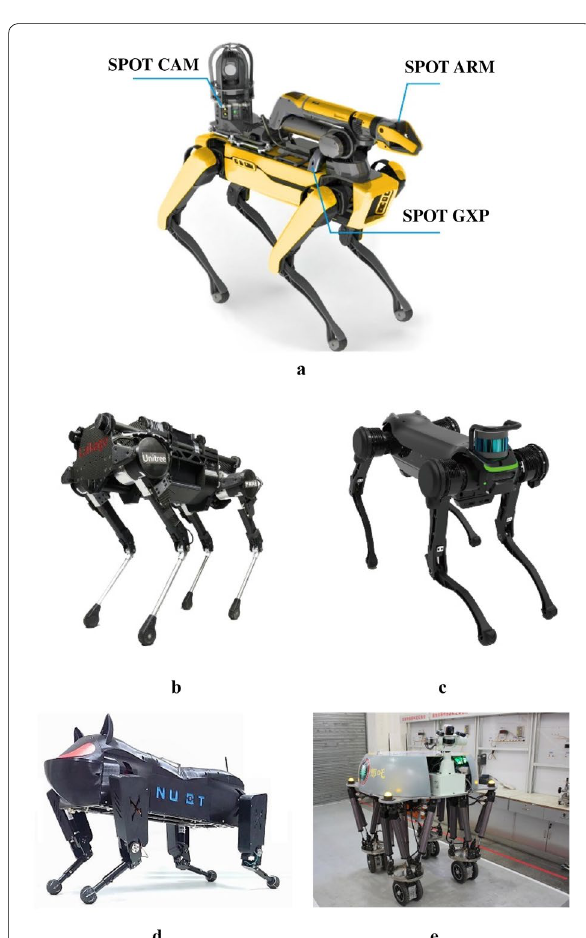
Figure 5 Commercial quadruped robots: a SPOT Mini; b Laikago; c Jueying; d XDog [29]; e